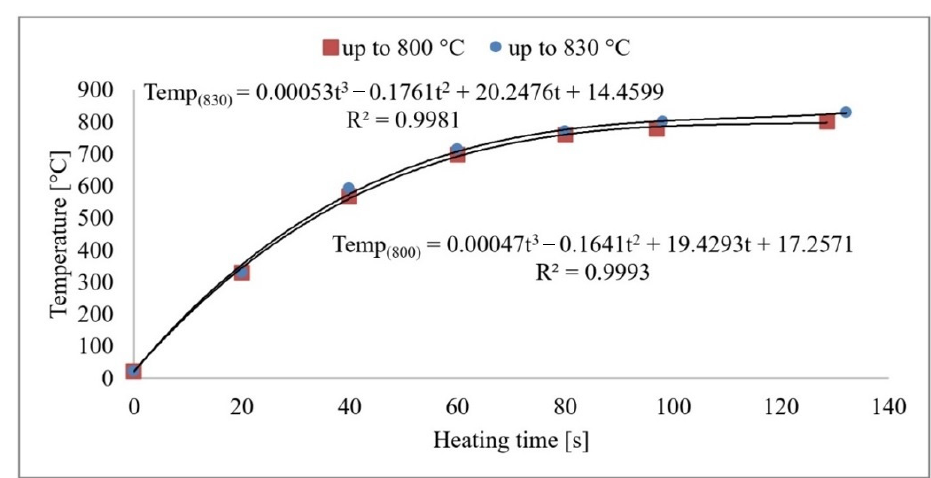
Figure 3. Sample core heating to 800 °C and 830